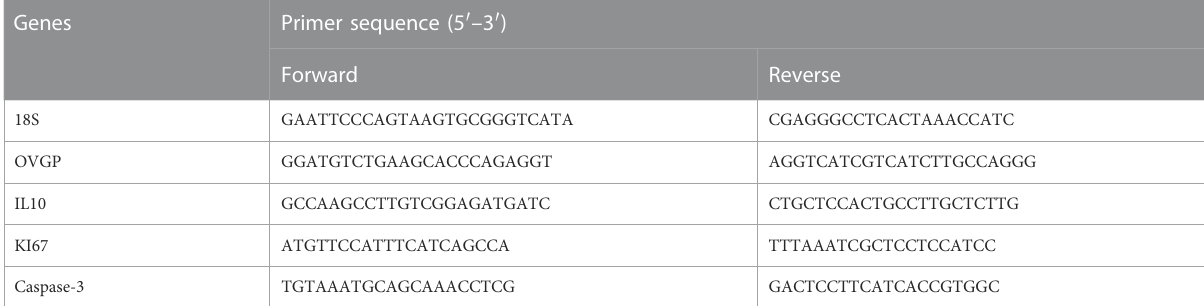
TABLE 1 Forward and reverse primer